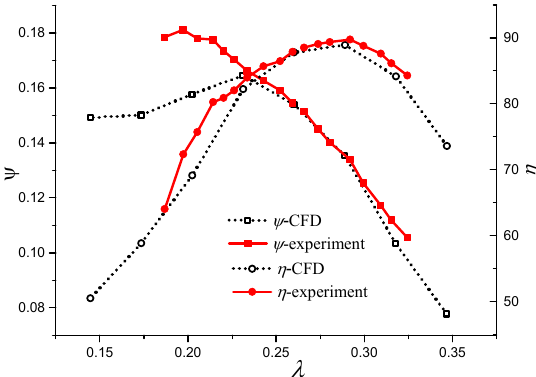
Figure 9. External characteristic analysis.